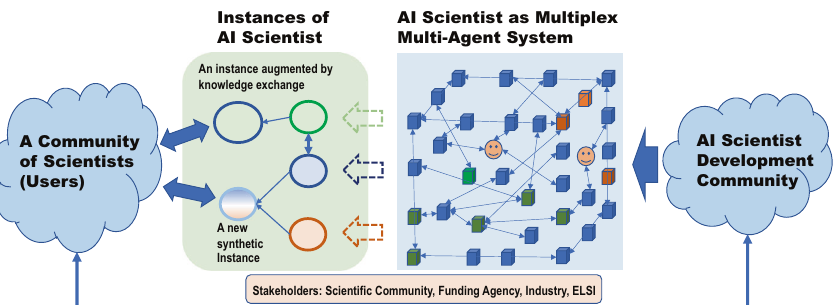
Fig. 10 A possible con fi guration of AI Scientists: AI Scientist is a multiplexed multi-agent system where multiple instances of AI Scientist will be created. They evolve, merge, and interact with humans. Human experts can be a part of the system as human-in-the-loop system. Scientists who wish to work with AI Scientist are most likely to work with instances of AI